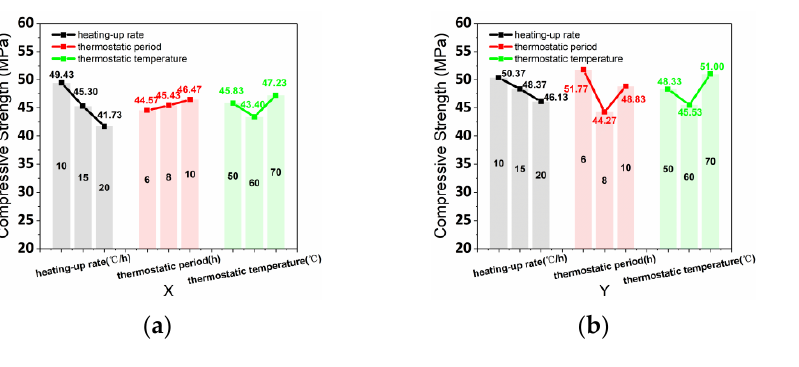
Figure 6. ( a ) CS x , ( b ) CS y , and ( c ) CS z affected by various heating-up rates, thermostatic periods, and thermostatic temperatures.